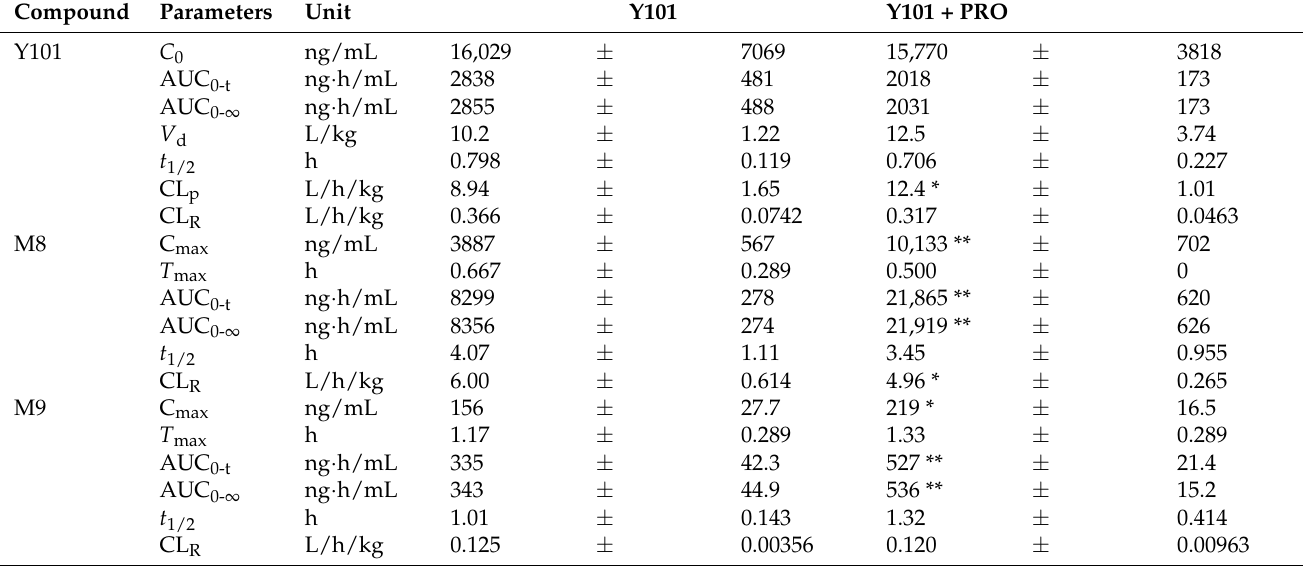
Table 1. Pharmacokinetic parameters of Y101, M8 and M9 after intravenous administration of Y101 (25 mg/kg) and Y101 + PRO (100 mg/kg). Data are expressed as mean ± SD (* p < 0.05, ** p < 0.01 vs. Y101 group; n =